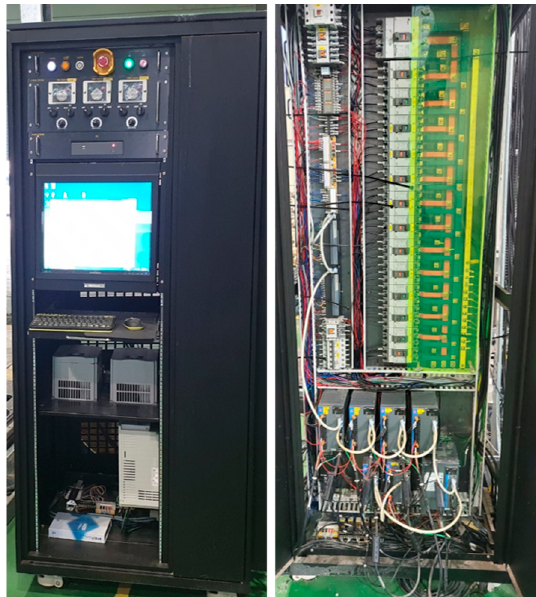
8 of 22 Figure 6. Configuration and structure of 3DCP control system [28].